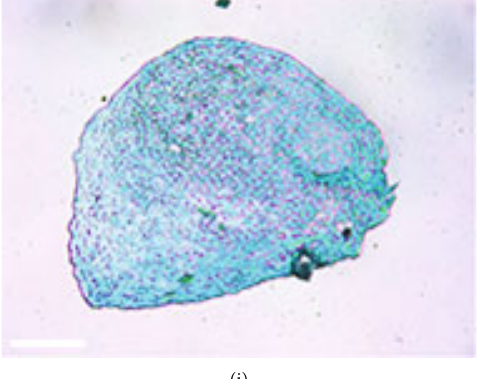
Figure 1: Identi fi cation of PDLSCs. (a) Imaging examination of immature permanent teeth. (b) Scraping the middle third of the root of the tooth. (c) The morphology of primary PDLSCs ( scalebar = 100 μ m ). (d) Morphology of the third-generation PDLSCs ( scale bar = 100 μ m ). (e) Flow cytometry assay showed that PDLSCs were positive for CD29, CD73, CD90, and CD105, but negative for CD34 and CD45. (f) Immuno fl uorescence assay revealed that PDLSCs were positive for STRO-1 ( scale bar = 50 μ m ). (g, h) PDLSCs had the potential to di ff erentiate into osteoblasts and adipocytes ( scalebar = 100 μ m ). On the left is the control group which was induced by complete medium. (i) PDLSCs had the potential to di ff erentiate into chondrocytes ( scalebar = 200 μ m